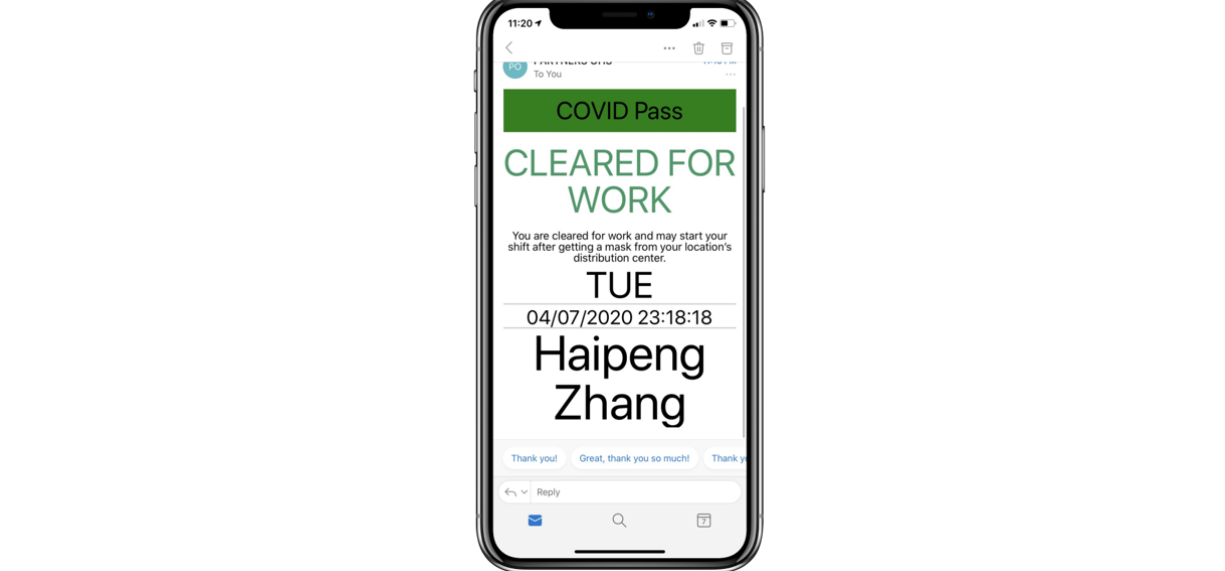
Figure 5. Screenshot of the .NET Framework version of COVID Pass.